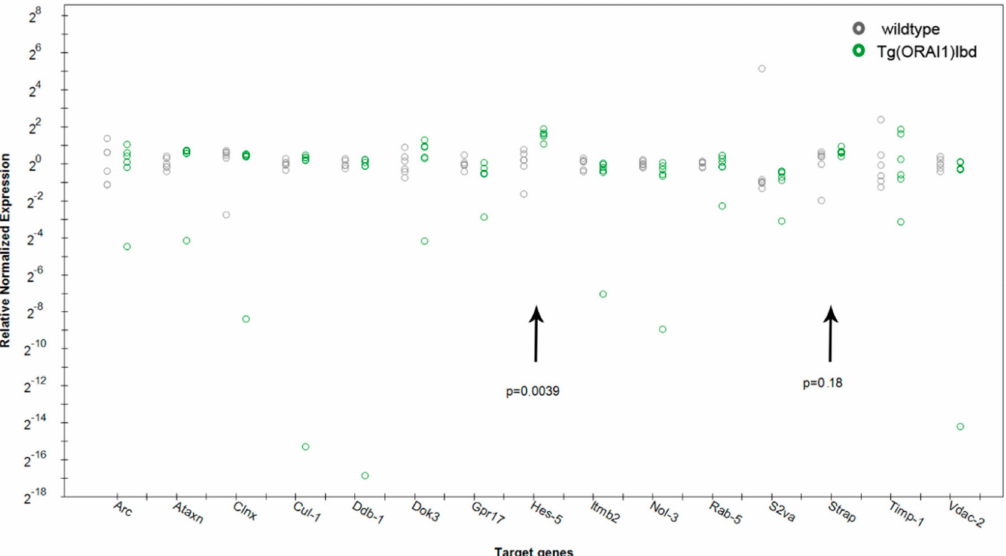
Figure 4. Expression profile of the selected genes in the hippocampi of the tested mouse variants that was obtained by real-time PCR analysis. The results are presented as scatter plot; each circle corresponds to one animal. The obtained results suggest an up-regulation of the expression of Hes-5 and Strap . The data are presented as a fold change (2 − ∆∆ Ct ) that was normalized to the reference gene ( Uba-2 ), the statistics was estimated by CFX software (Bio-Rad) using post hoc method (Tukey’s